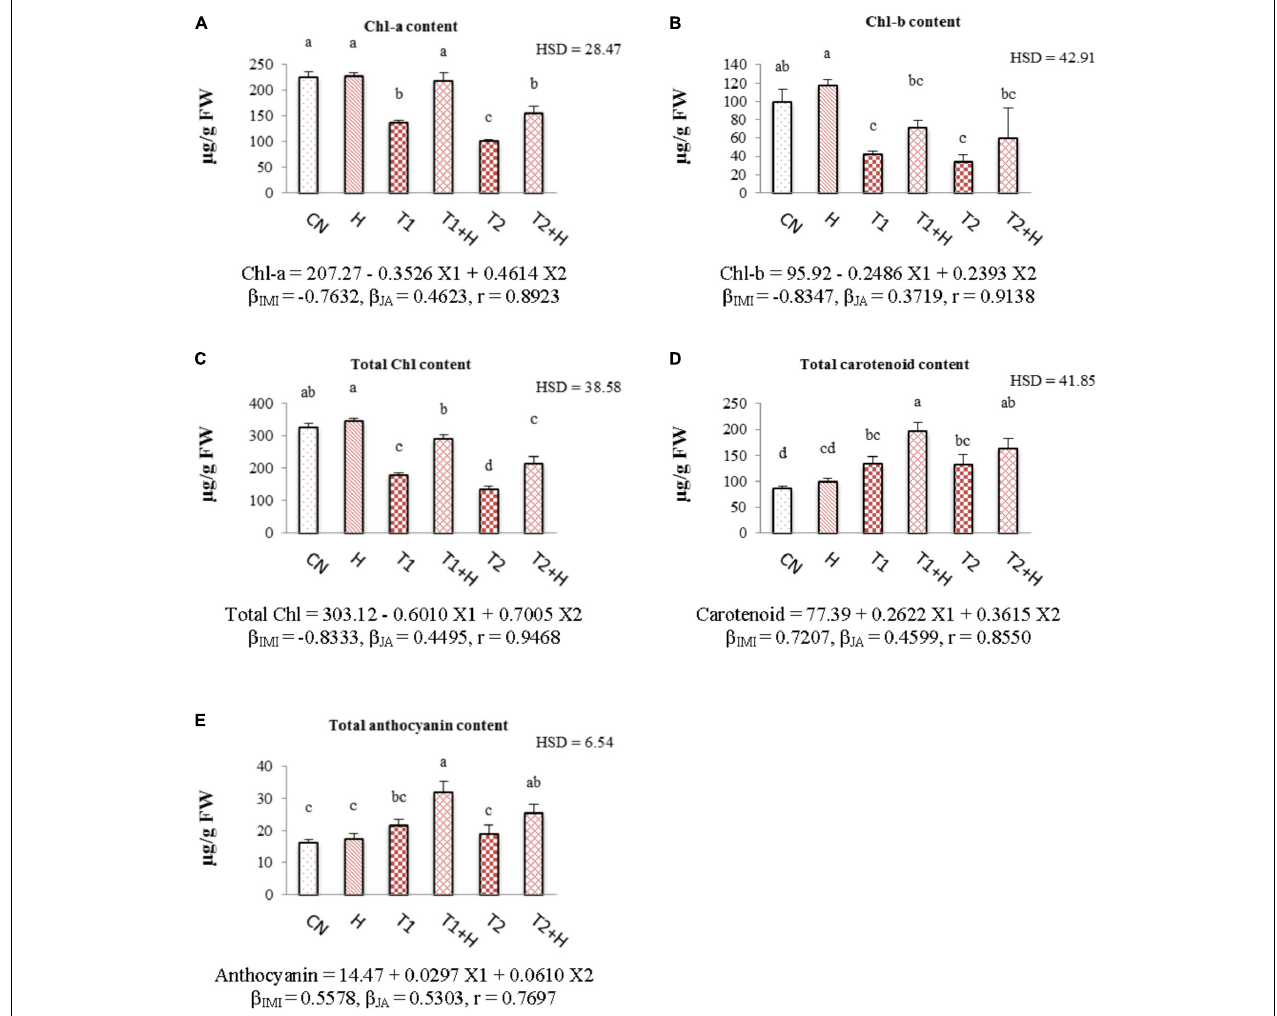
FIGURE 3 | Effect of JA seed soaking on the contents of pigment system in B. juncea seedlings under IMI stress. Data shown here are mean ± SD ( n = 3). Means with same letters are not significantly different from each other, IMI, imidacloprid (X1); JA, jasmonic acid (X2); T1, 200 mg · L − 1 (IMI); T2, 250 mg · L − 1 (IMI); H, 100 nM (JA); r, multiple correlation coefficient. β = β -regression coefficient. A = chl-a; B = chl-b; C = total chl; D = carotenoid; E =